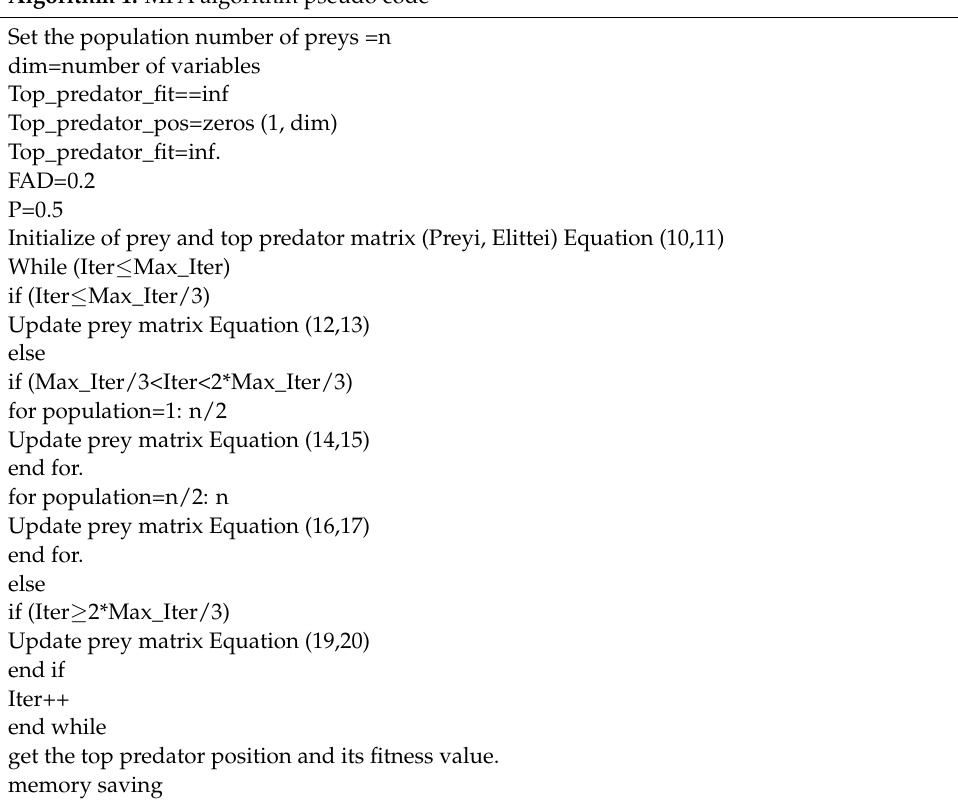
Algorithm 1. MPA algorithm pseudo